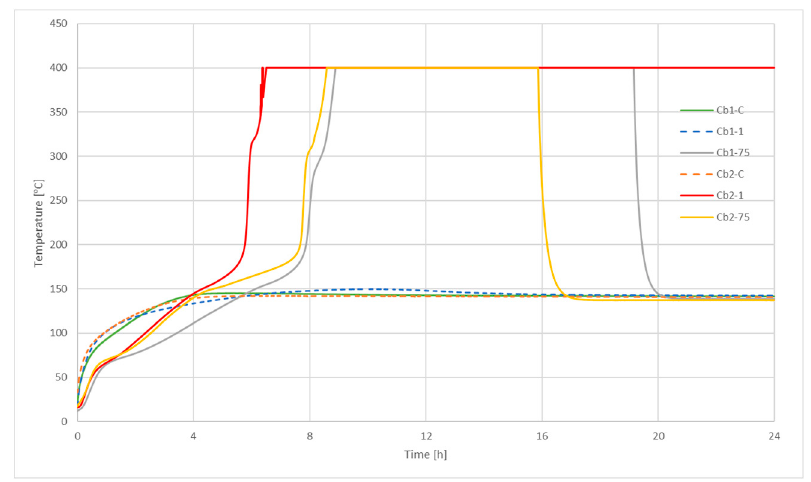
Figure 1. United Nations N4.2 Test for charcoal.